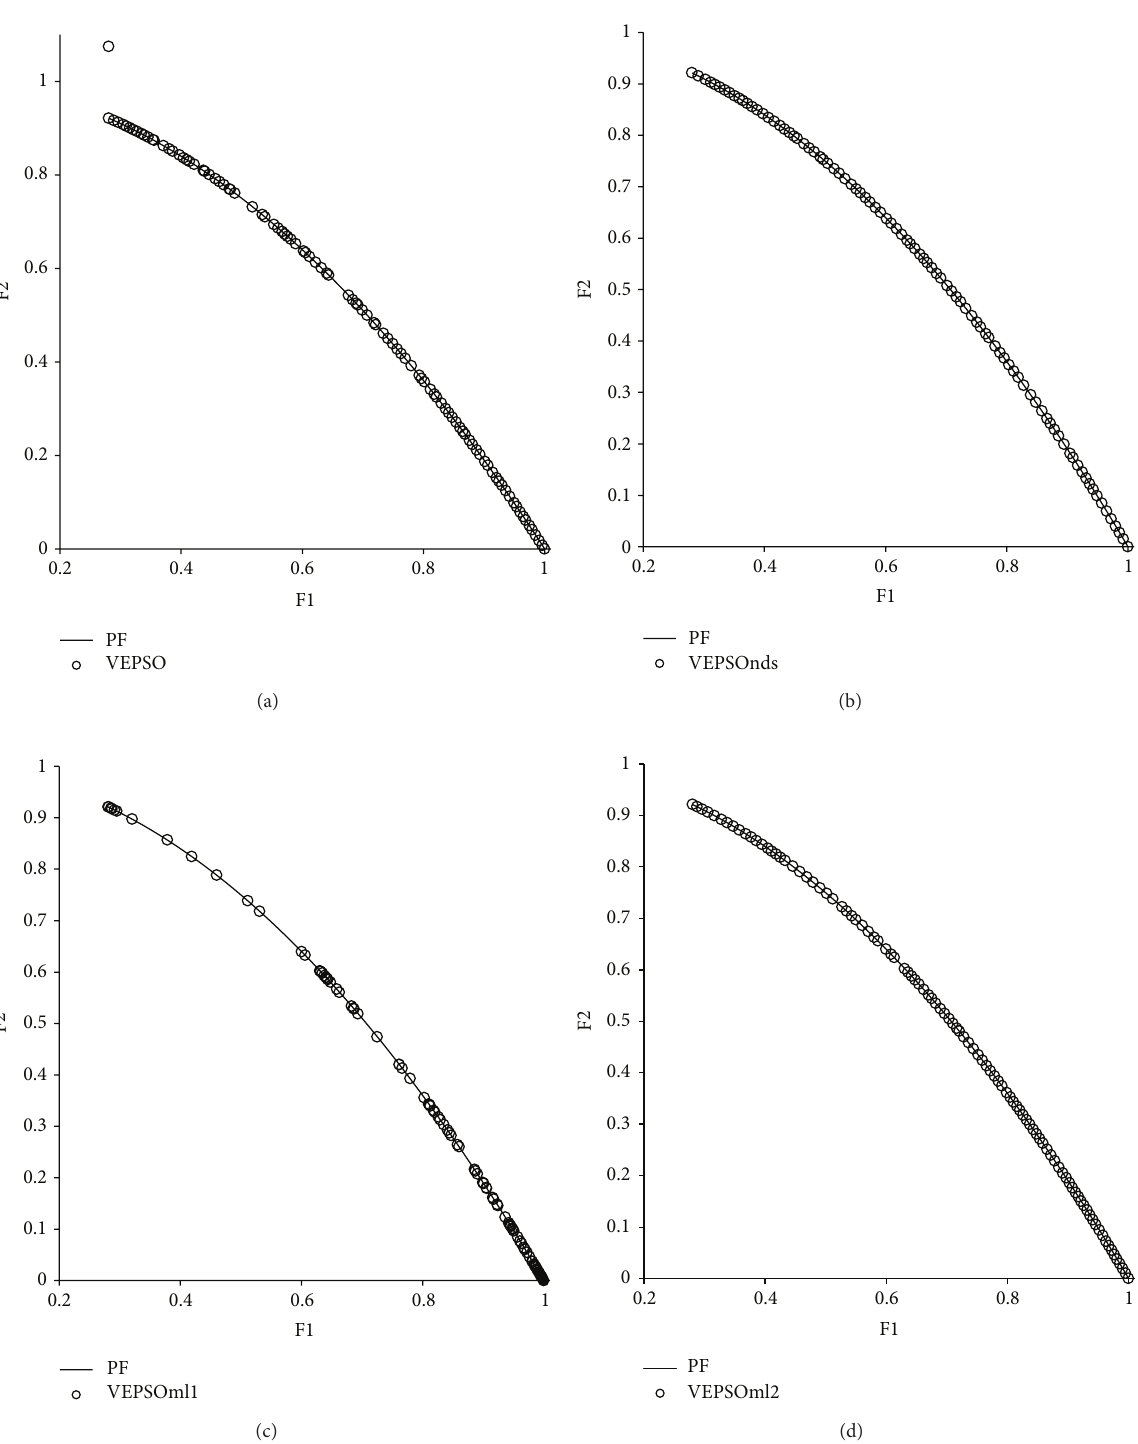
Figure 10: Plot of nondominated solutions returned by each algorithm for the ZDT6 test